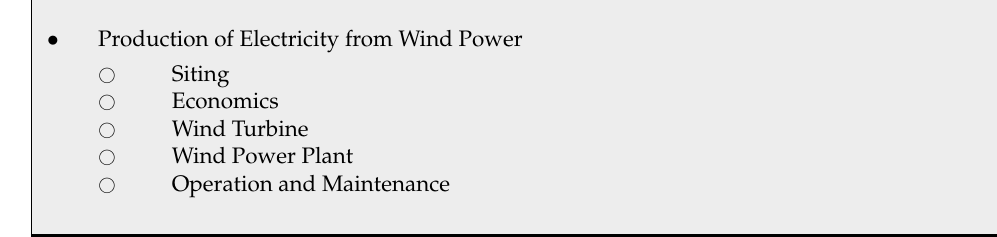
Table 11. Hierarchy for Production of Electricity from Wind